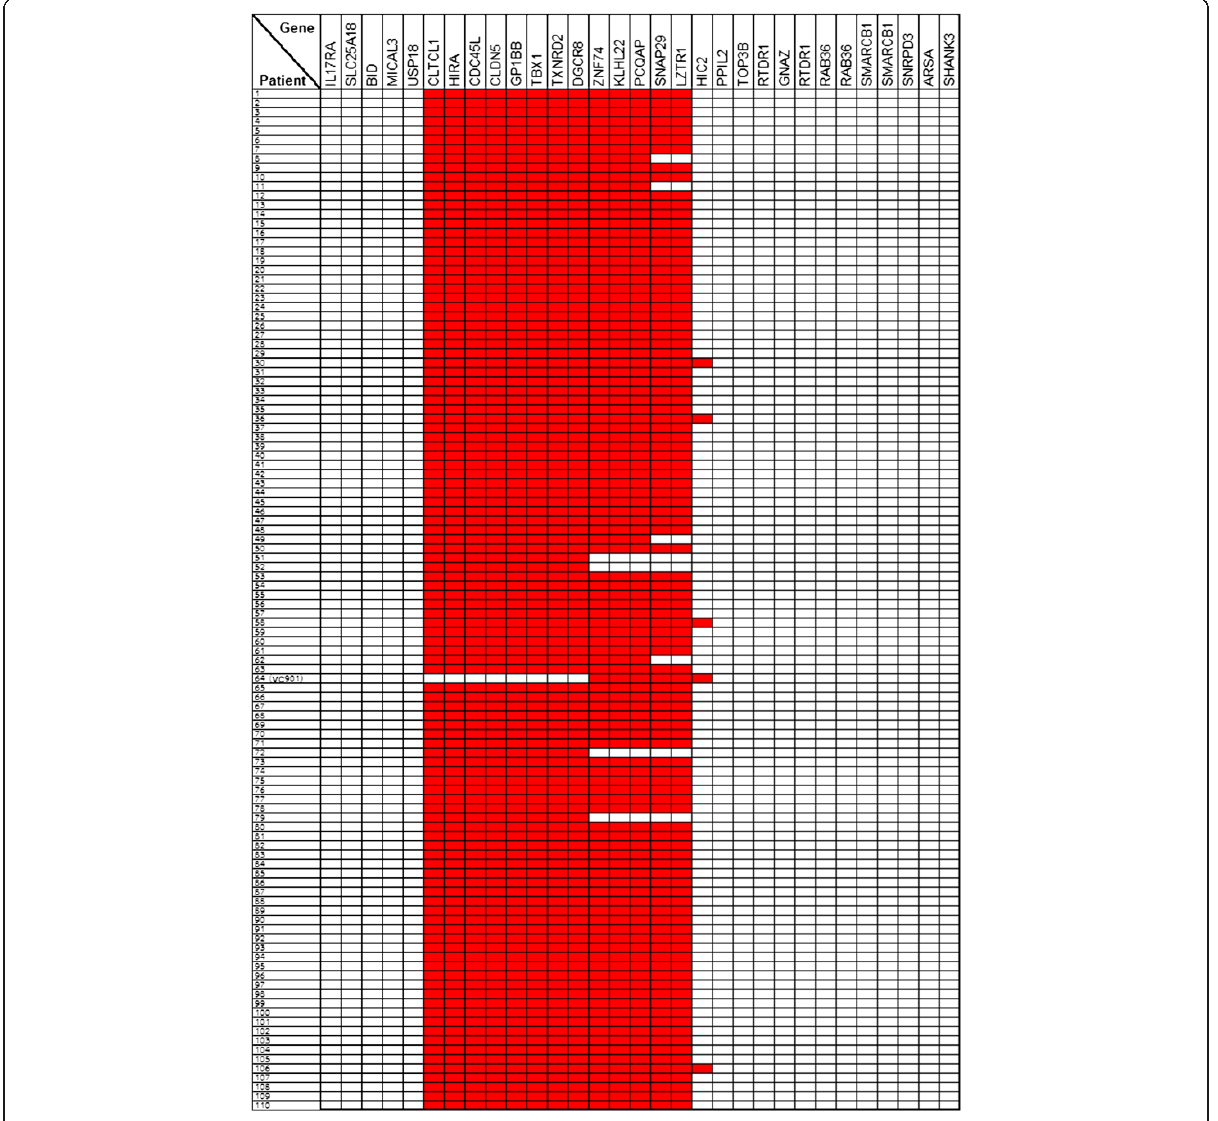
Figure 1 MLPA results for 110 individuals with 22q11.2 deletion. Shown below are 30 gene probes within 22q11.2 region (MLPA-P250 kit) which were used for identifying the copy number variation. The copy number is indicated by color: red- one copy (hemizygous deletion); white- two